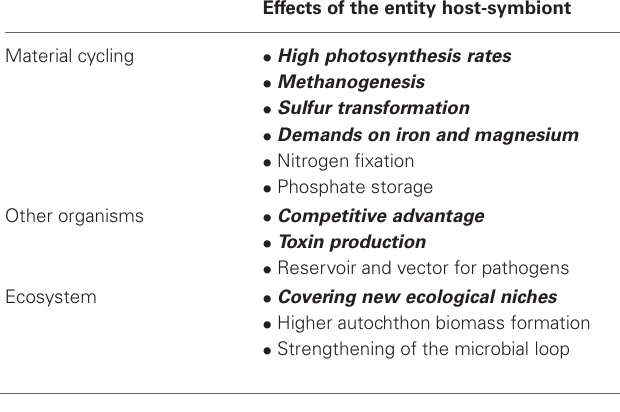
Table 1 | Effects of symbiosis on ciliate hosts and